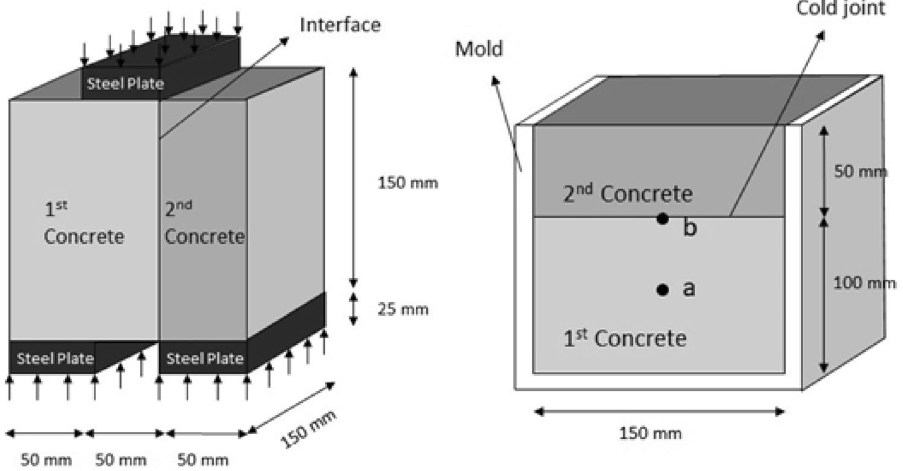
Fig. 3 Schematic of measuring adhesion resistance by two- level cutting